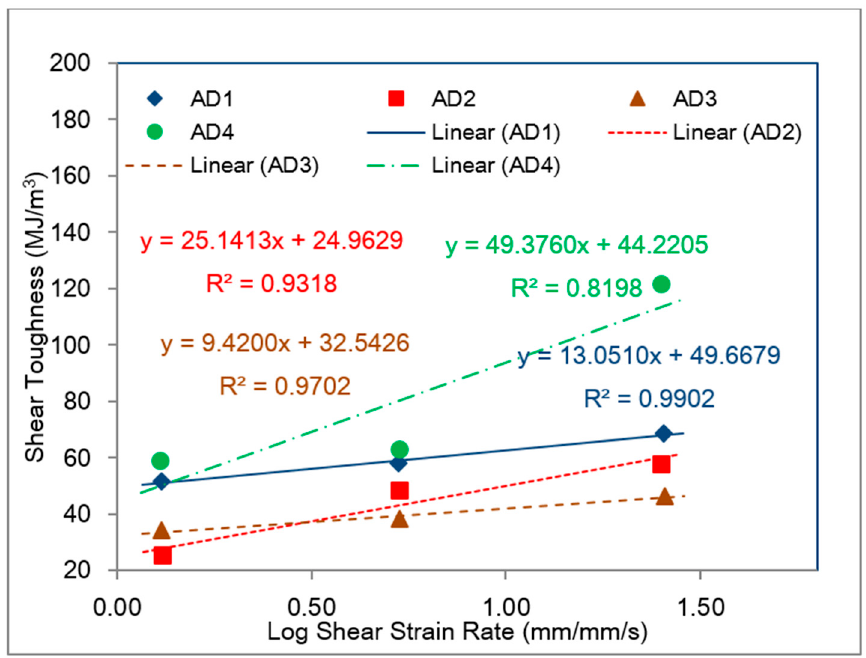
Figure 24. Average bonded single lap shear toughness–shear strain rate behavior of Phase 1 model adhesives.